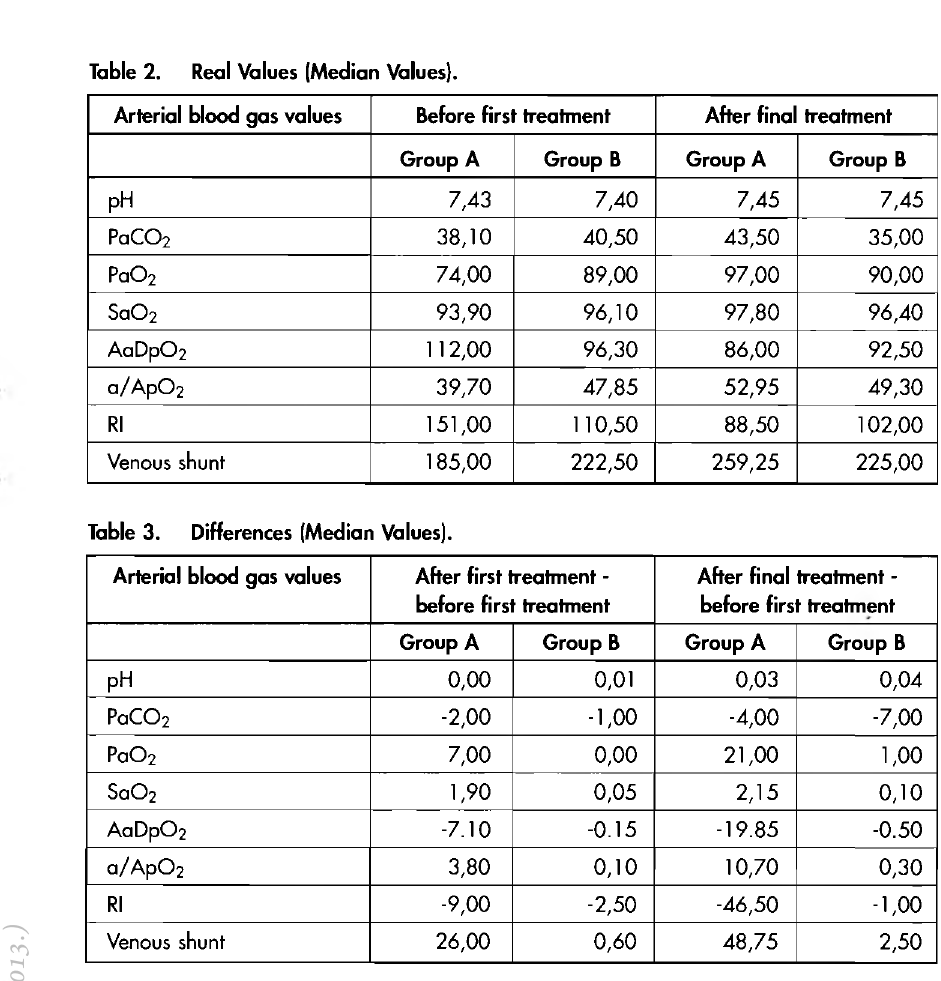
Differences (Median